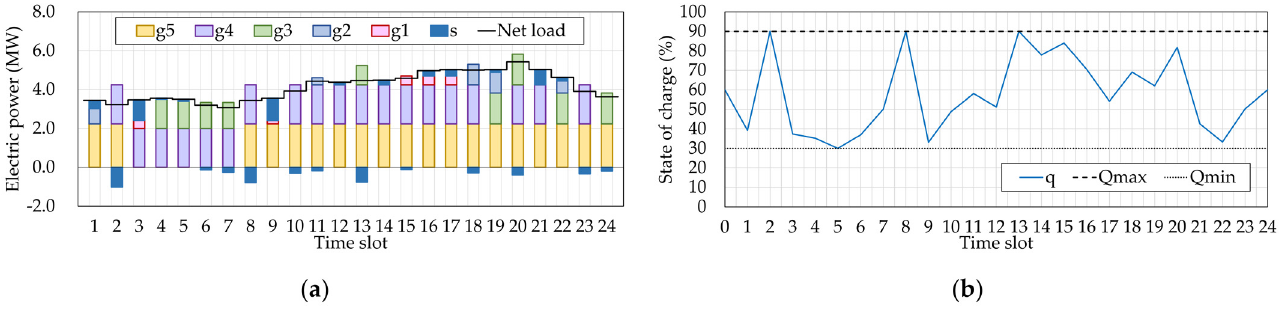
Figure 5. Obtained solution in Case 2 ( Q = 2.00 (MWh)): ( a ) operation schedule; ( b ) transition of SOC level.